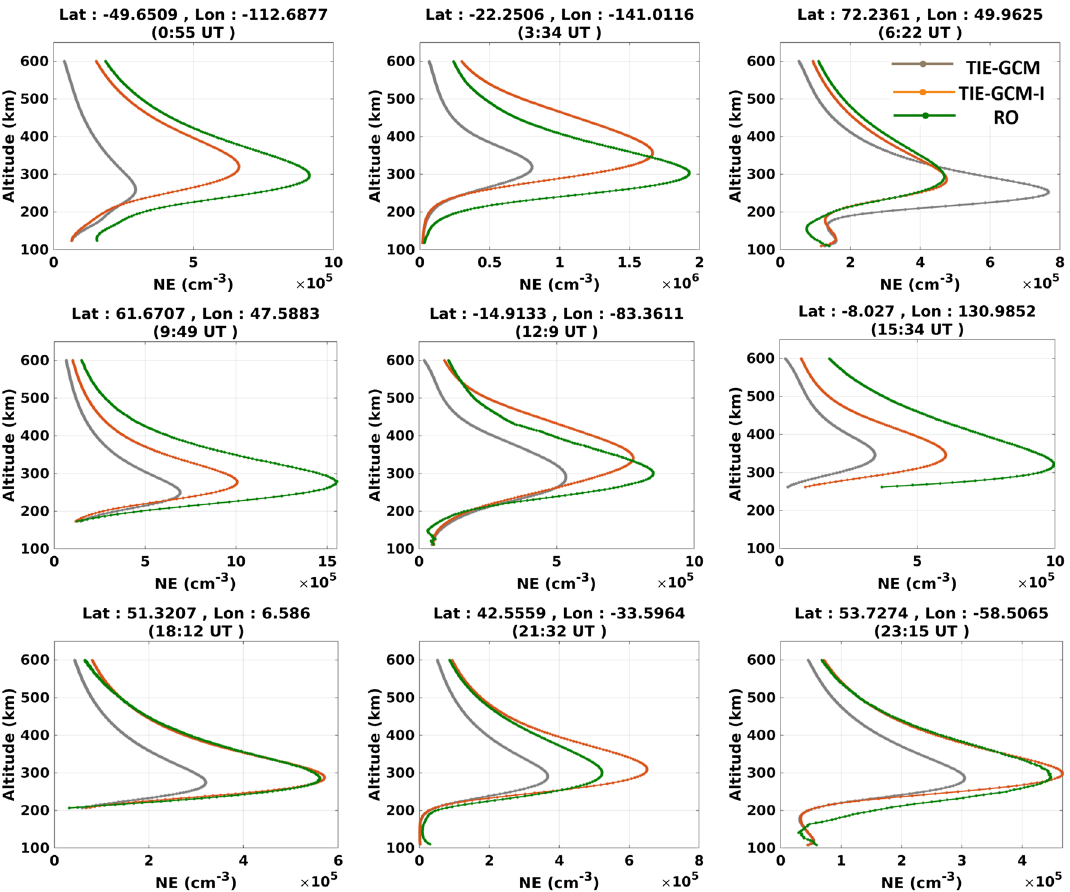
Figure 11. The altitude-dependent profiles of Ne retrieved from the COSMIC radio occultation data, as well as the original TIE-GCM, and TIEGCM-I during 24 h of February 8th, 2015. The plots were generated using MATLAB (version R2021a, https:// www. mathw orks.